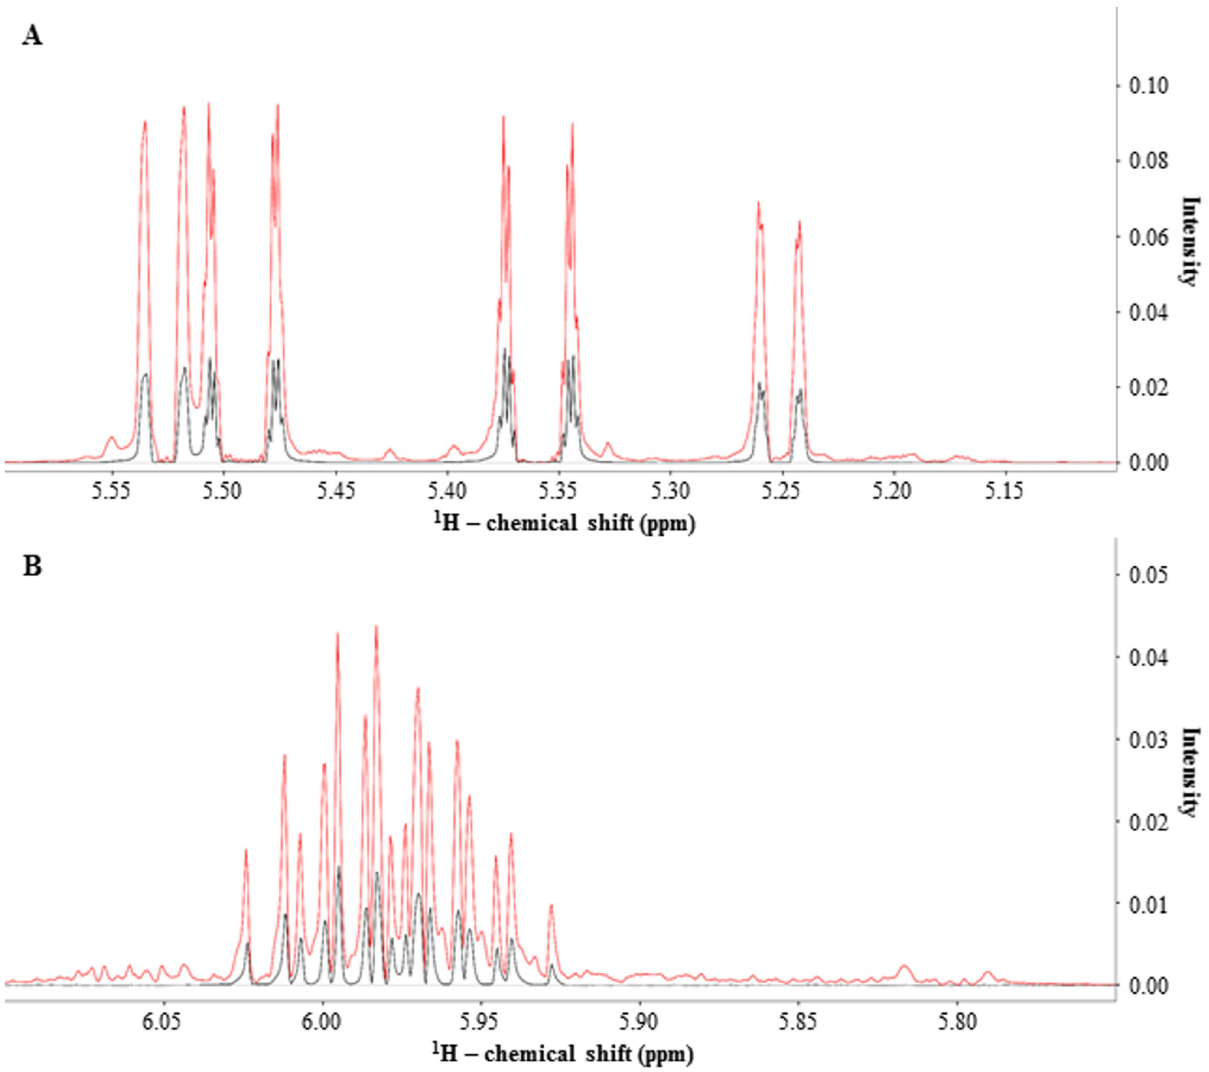
Fig 2. Identity of unknown determined to be an organosulfur compound originating from garlic known as allicin. An overlay of 1D 1 H NMR spectra (600 MHz, 10% D 2 O) in chemical shift regions (A) 5.1–5.6 ppm and (B) 5.75–6.1 ppm for an allicin standard (black) and ES-GBBr formulation SM-NP fraction